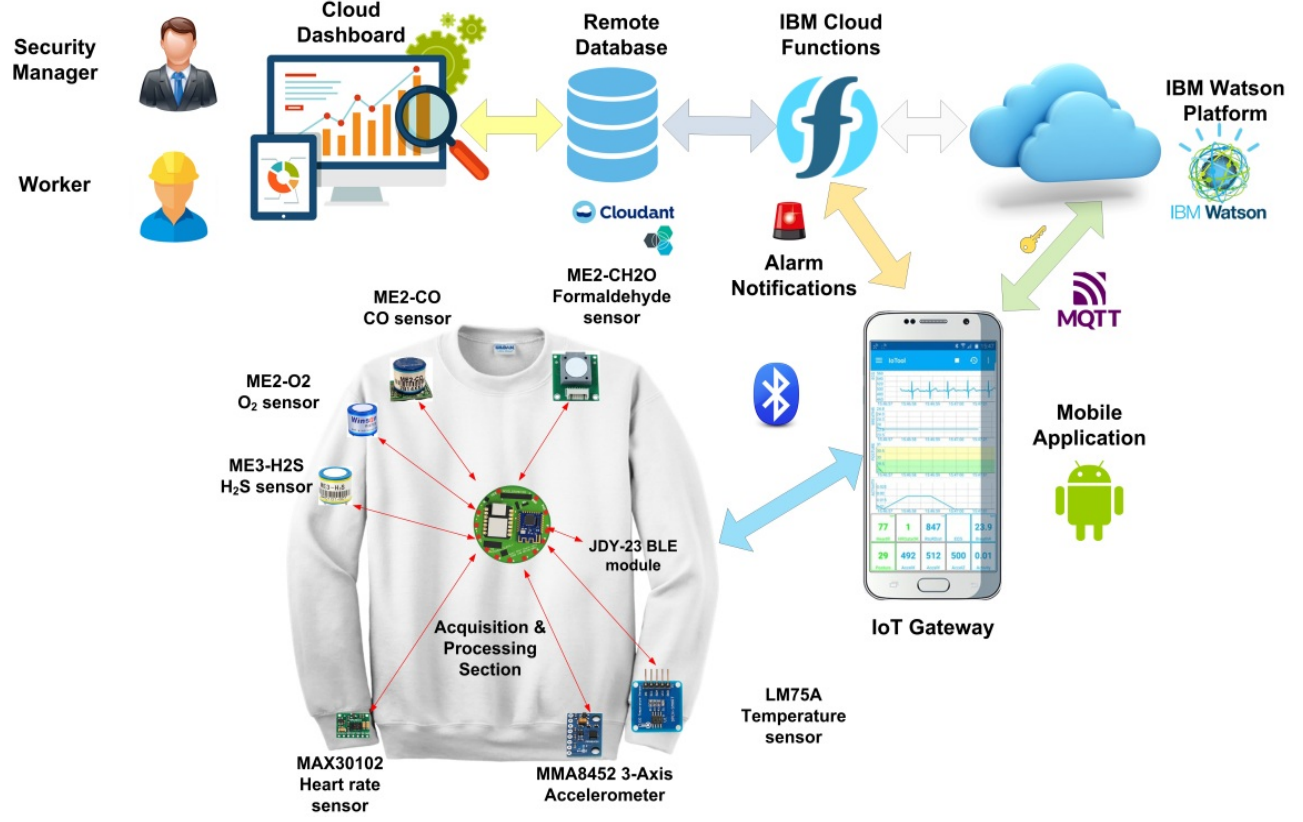
Figure 1. Graphical illustration of the deployed monitoring system relying on the proposed wear- able device.